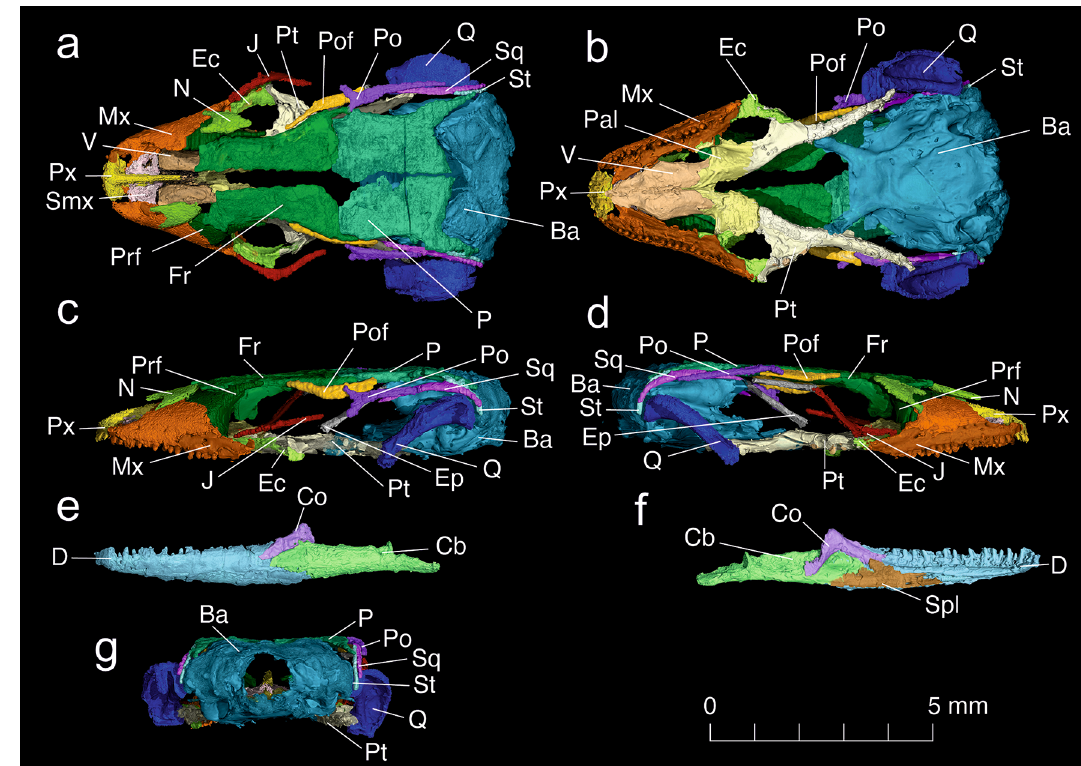
Figure 3. Skull of Retinosaurus hkamtiensis (GRS 29689) based on X-ray microcomputed tomography (synchrotron data). Individual bones segmented using VGSTUDIO MAX (Volume Graphics GmbH), rendering each bone as a volume. Cranium in dorsal ( a ), ventral ( b ), left lateral ( c ), right lateral ( d ), and posterior ( g ) views, Jaw in lateral ( e ) and medial ( f ) views. Ba braincase, Cb compound bone, Co coronoid, D dentary, Ec ectopterygoid, Ep epipterygoid, Fr frontal, J jugal, Mx maxilla, N nasal, P parietal, Pal palatine, Po postorbital, Pof postfrontal, Prf prefrontal, Pt pterygoid, Px premaxilla, Spl splenial, Q quadrate, Smx septomaxilla, Sq squamosal, St supratemporal, V